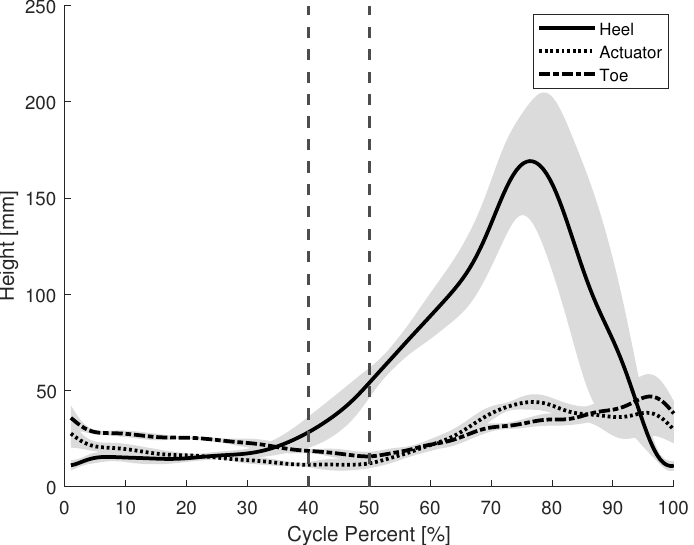
Figure 14. Brake activation timing during the gait of an individual with